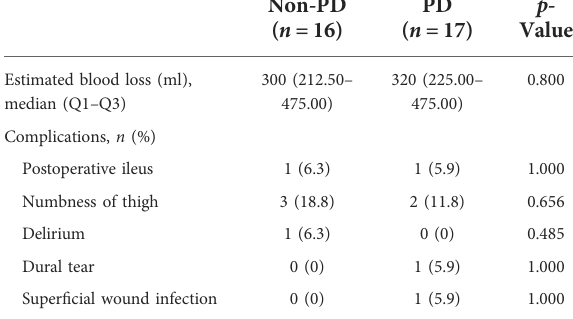
TABLE 5 Perioperative parameters and postoperative